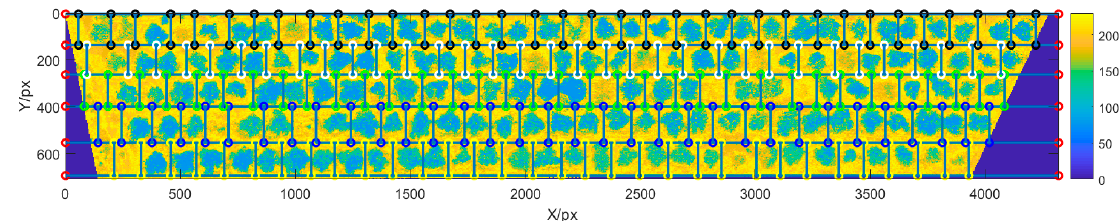
Figure 3. Row and column detection results with orchard canopy data.